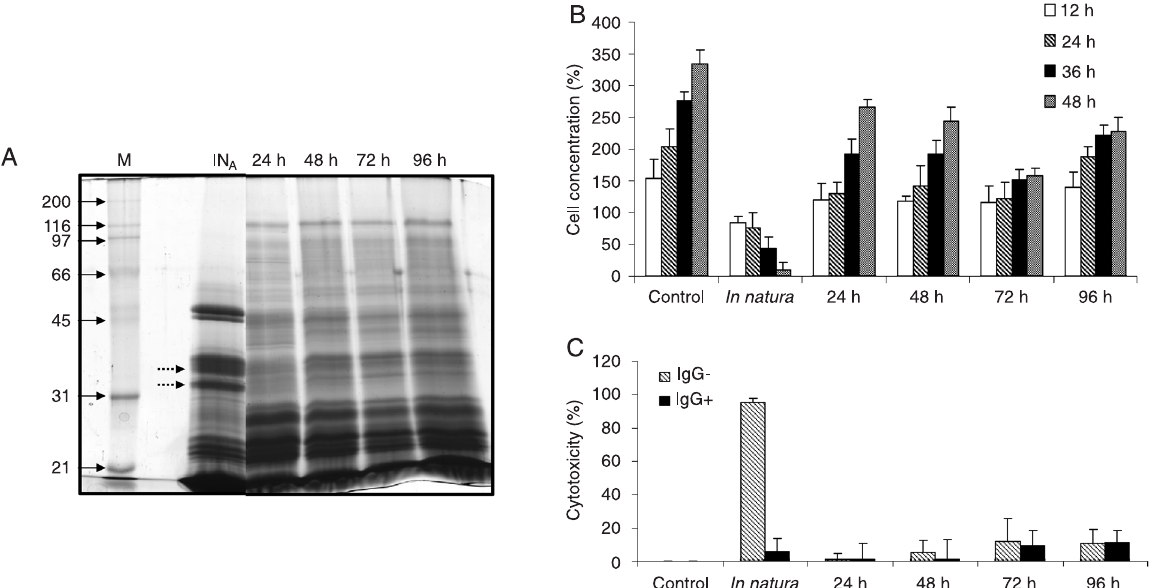
Figure 3. Toxicity of the fermented castor cake. A , SDS-PAGE (12%) of proteins extracted from in natura (IN A ) and fermented (24, 48, 72, and 96 h) castor cake. Lane M = DNA marker. Twenty micrograms of protein was loaded in each lane. B , Cell concentration estimated by cell counting after cell growth for 12, 24, 36, and 48 h. Control cells = cells grown in DMEM; In natura = cells grown in the presence of castor crude cake; 24, 48, 72, and 96 h = times of fermentation (cells grown in the presence of fermented cake). C, Cytotoxicity of fermented cake incubated or not with ricin anti-A chain antibody (IgG+ and IgG-, respectively) measured using a lactate dehydrogenase activity